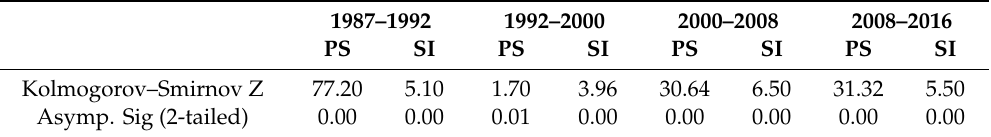
Table 2. Two-sample Kolmogorov–Smirnov Z test values for woody patch size (PS; ha) and patch shape index (SI) from 1987 to 2016 in the Rio Grande Delta and surrounding rangeland study area (10,065 km 2 ) in South Texas, United